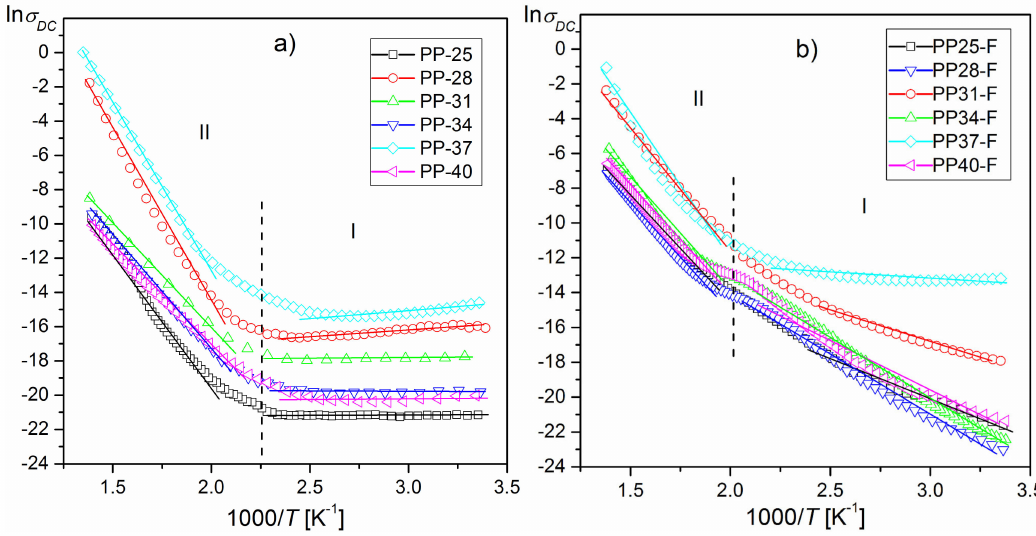
Figure10. Influenceof x (PT)inPPceramics( a )andPP-Fcompositesamples( b )onln σ DC (1000 / T